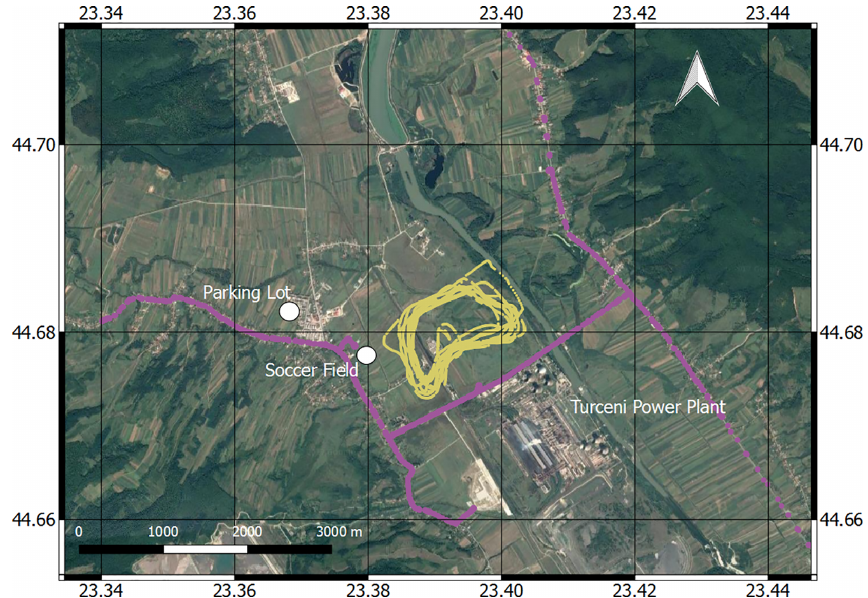
Figure 4. The set-up in Turceni during the AROMAT campaign. The yellow loops indicate the UAV tracks during the first flight on 11 Septem- ber 2014, while the pink line shows the roads simultaneously used by the mobile DOAS.